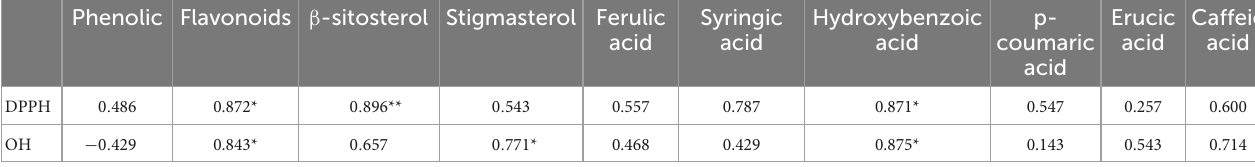
TABLE 3 Correlation analysis between bioactive compounds and the antioxidant